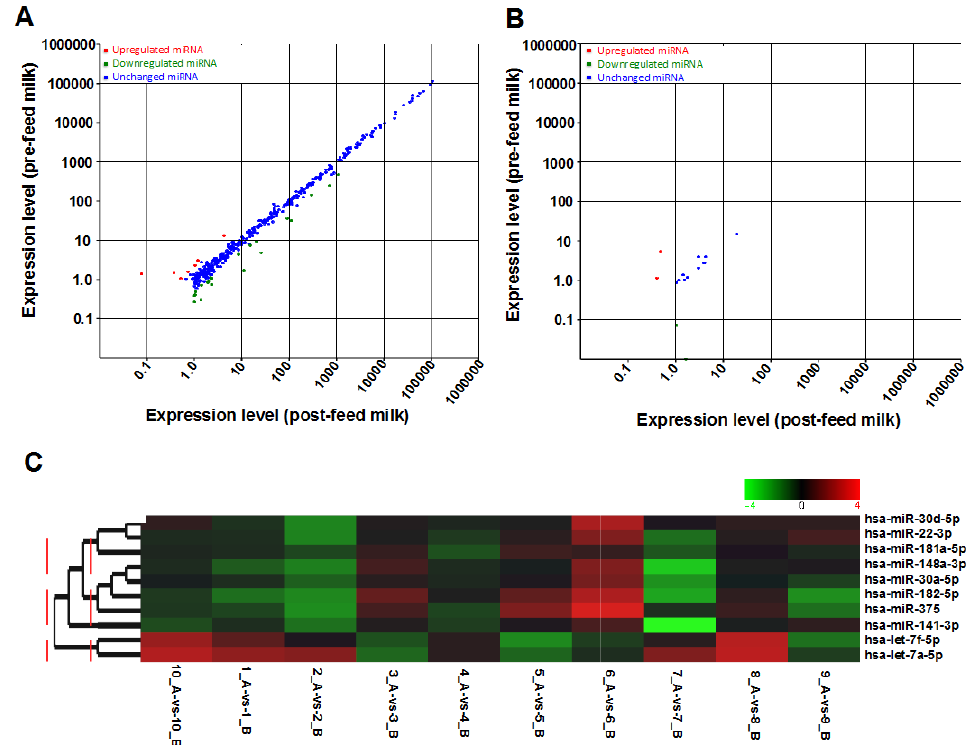
Figure 4. The two differential expression scatter plots show all identified known ( A ) and novel ( B ) miRNAs that were expressed in all pre-and post-feed milk samples ( n = 10 samples in each group). Each red and green dot represents an individual miRNA that is either up- or down-regulated between pre- and post-feed milk, respectively, whilst blue represents no difference in expression level; ( C ) Heat-map demonstrating the relationship and expression patterns of the top 10 most highly expressed miRNAs between pre-(B) and post-(A) feed milk of individual participants. The expression patterns were analyzed hierarchically by clustering these 10 miRNAs, where green refers to low expression and red refers to high expression level.